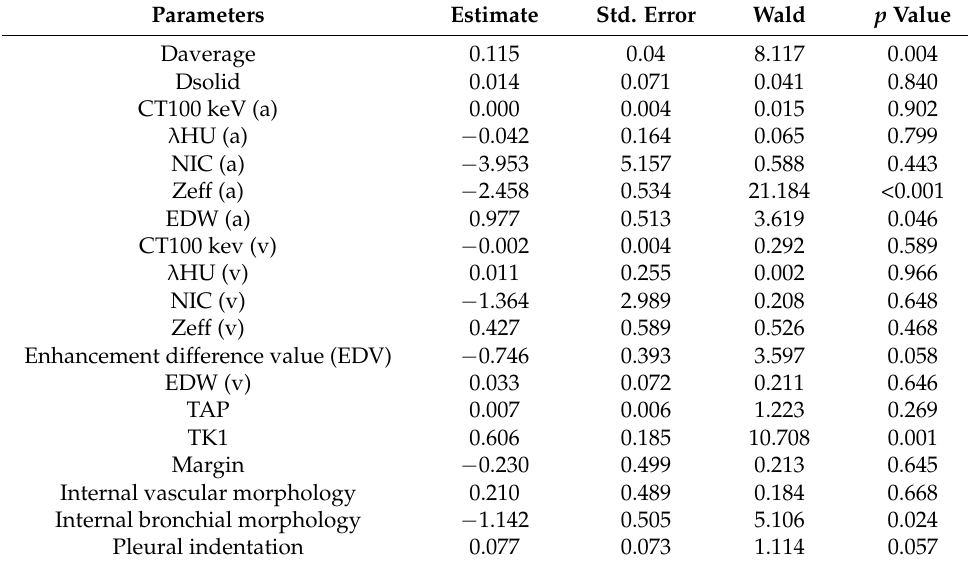
Table 3. Multifactorial analysis of GGN invasiveness.